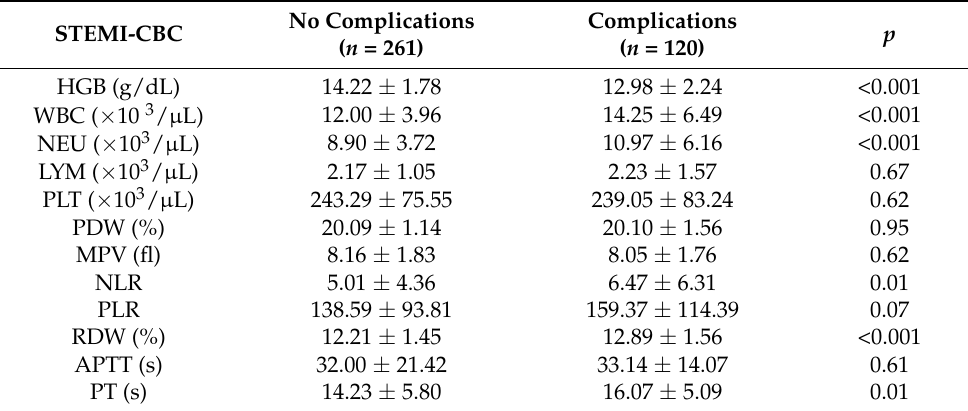
Table 6. Hematological and coagulation parameters of the groups with/without in-hospital compli- cations in STEMI